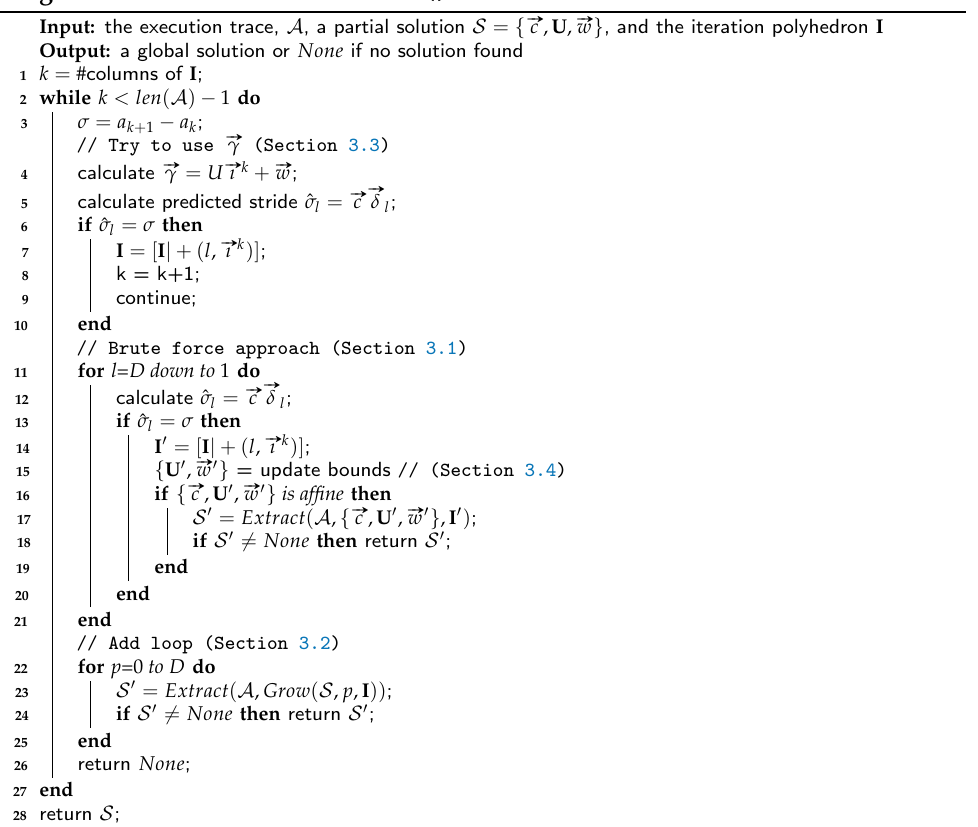
Algorithm 1: Pseudocode of Extract()